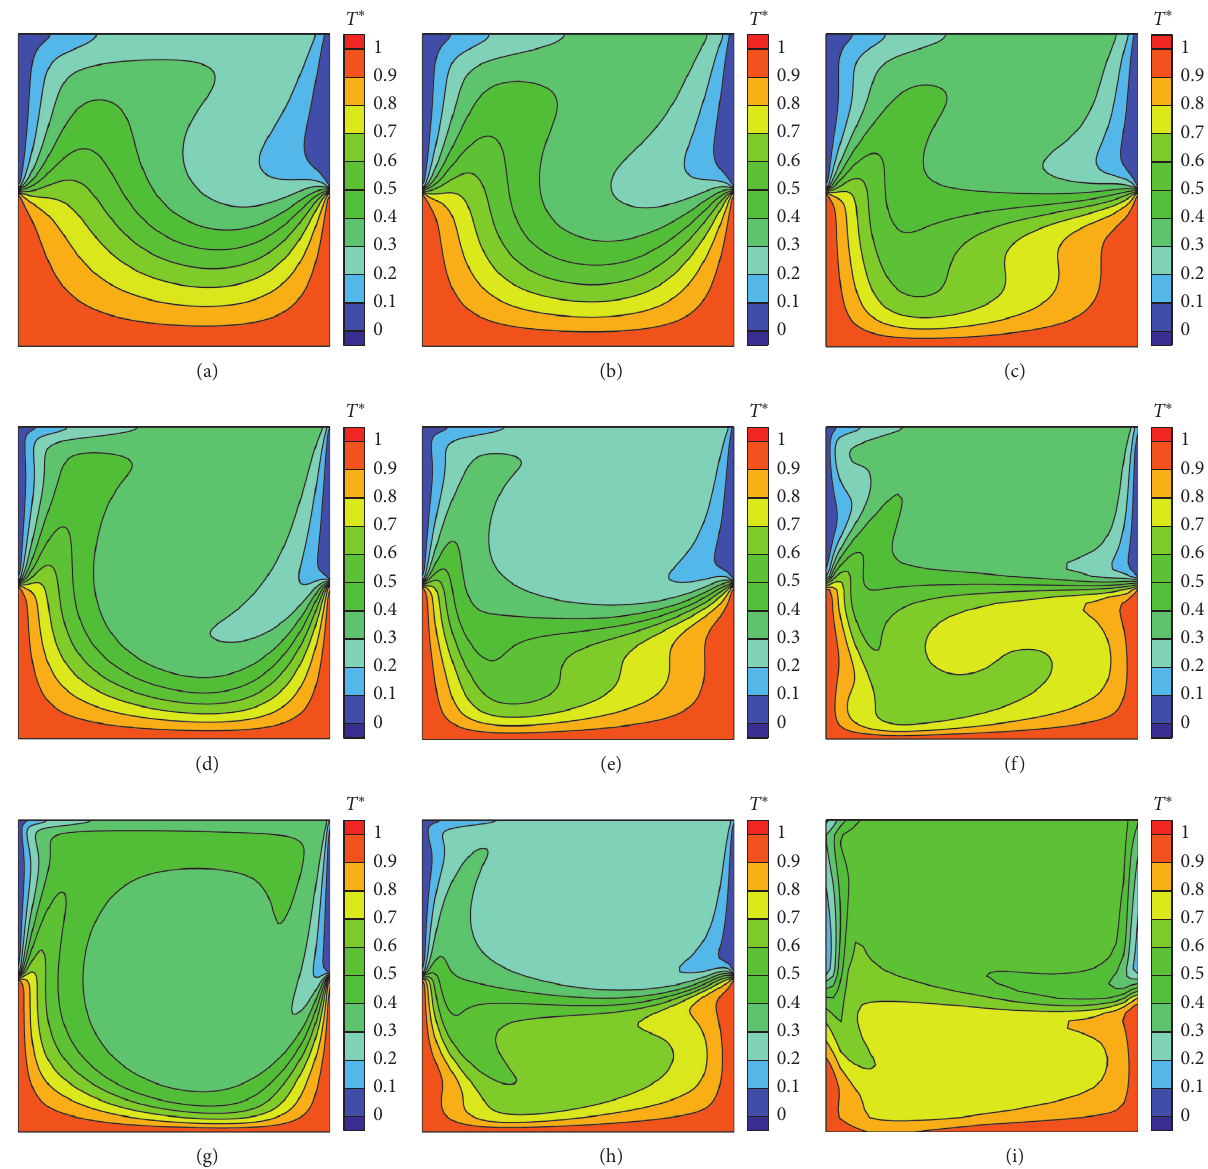
Figure 3: Simulated isotherms for different Re and Ri values. (Re, Ri) � (a) (100, 0.001), (b) (100, 1), (c) (100, 10), (d) (400, 0.001), (e) (400, 1), (f) (400, 10), (g) (1000, 0.001), (h) (1000, 1), and (i) (1000,